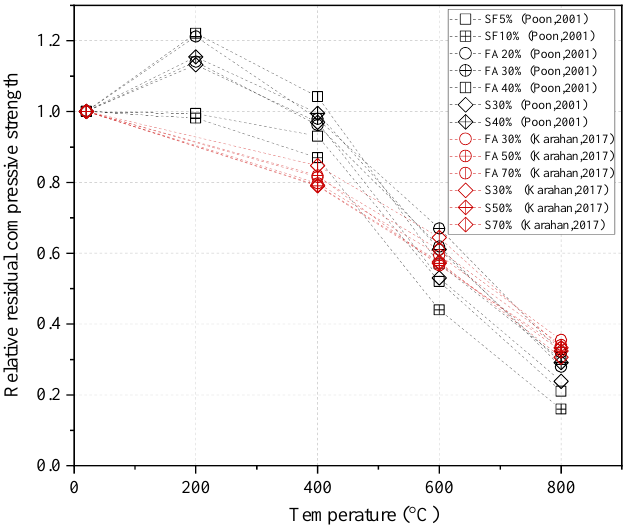
Figure 17. The relative residual compressive strength of concrete with different SCMs: silica fume (SF), fly ash (FA), and slag(S) [35,39].